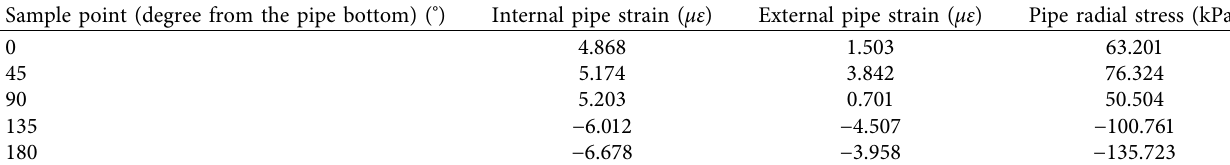
Table 3: The sample point data of the